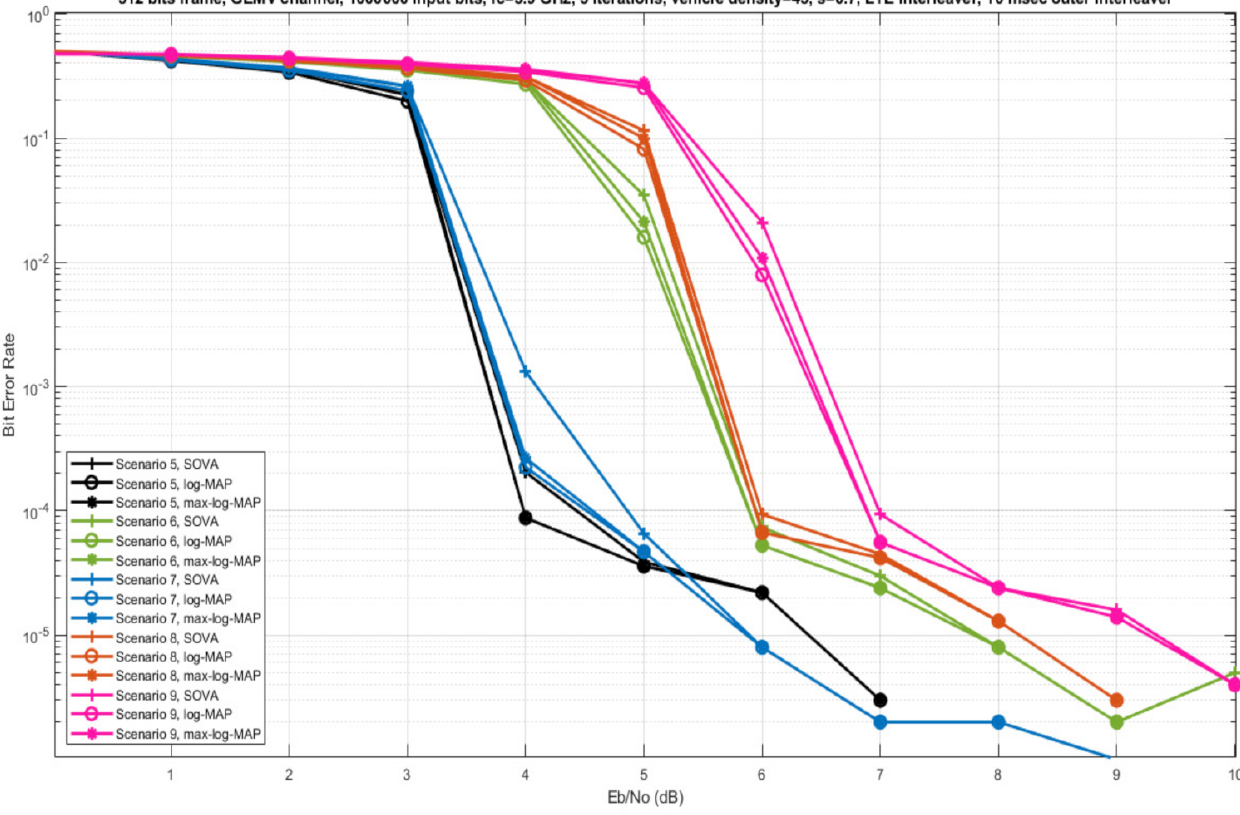
Figure 3. BER vs. SNR for GEMV channel, 5 different Table 2 scenarios, different decoding algorithms, 3 iterations, frame length of 512